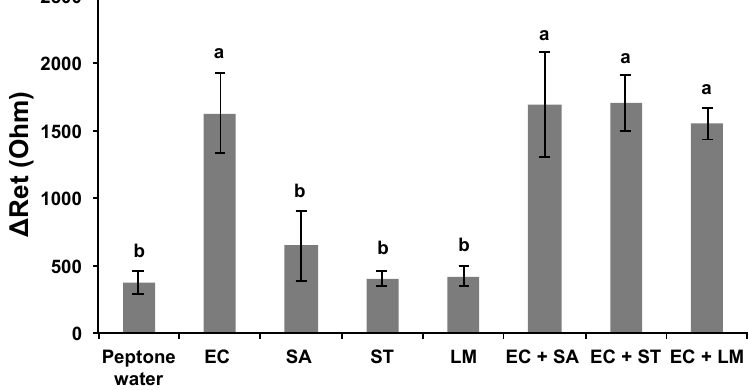
Figure 6. Changes in electron transfer resistance with E. coli K12 captured on the electrode surface of the E. coli MEI sensor in pure E. coli K12 solution. Error bars indicate the standard deviation of the mean. Different letters (a–f) in the figure indicate significant differences ( p ≤ 0.05). When the E. coli MEI sensor was used for the detection of nontarget bacteria, such as SA, ST, and LM, the value of Δ R et ranged between 400 and 645 Ω ; however, the signal increased to 1629 ± 295 Ω when the same sensor was used for EC (Figure 7). There were no significant differences in Δ R et values between pure and cocktail samples for the equivalent amount of E. coli K12 cells either. The values obtained for mixed samples EC + SA, EC + ST, and EC + LM were 1696 ± 390 Ω , 1702 ± 207 Ω , and 1553 ± 117 Ω , respectively, very close to the signal magnitude for EC sample. SEM images present captured E. coli K12 on the surface of the E. coli MEI sensor (Figure 8a,b). Most of the bacteria attached to the surface of the E. coli MEI sensor were observed as E. coli K12 cells after the E. coli MEI sensor was tested with the mixture of E. coli K12 and S. aureus , shown in Figure 8b. FESEM also indicated that the surface of the E. coli MEI sensor remained clear, which means no bacteria were captured under DEP when the sensor was dipped into the pure S. aureus solution (Figure 8c).